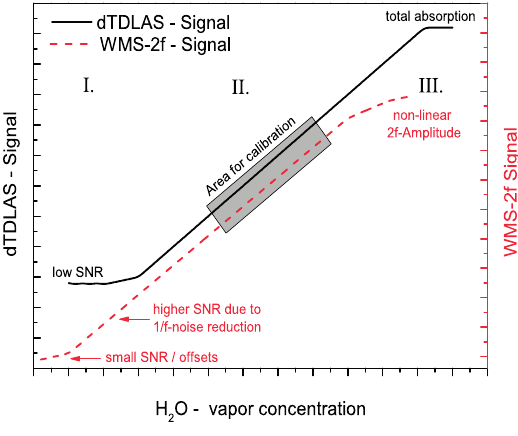
Figure 4. Schematic of the on-the-fly WMS calibration using quasi simultaneous rapid time multiplexed dTDLAS/WMS